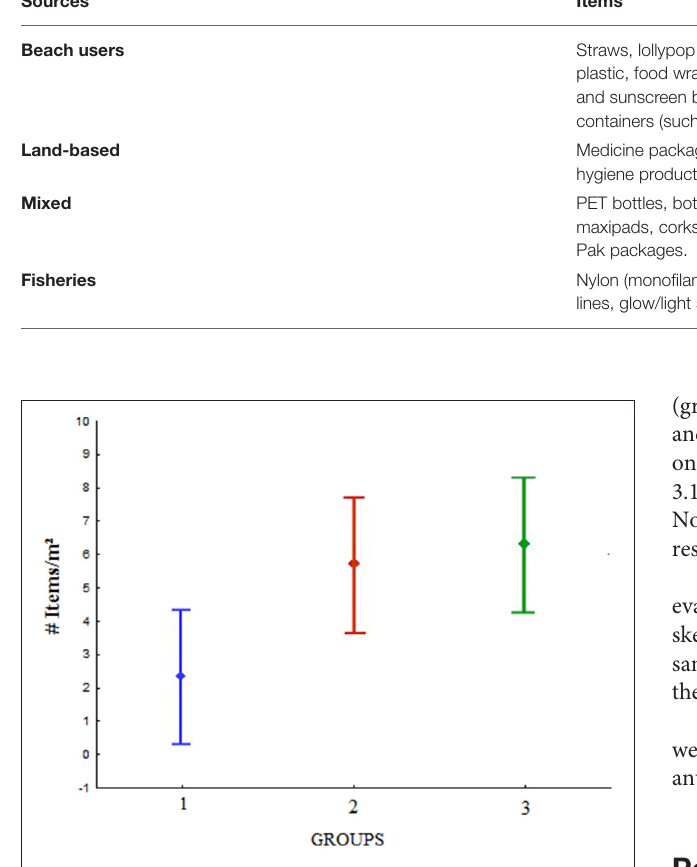
TABLE 2 | Classification of anthropogenic litter items according to the most likely source (Silva-Iñiguez and Fischer, 2003). Sources